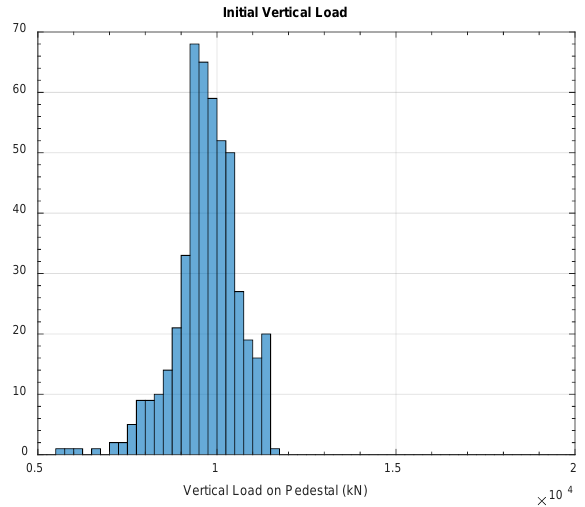
Figure 19. Initial vertical load on the isolators.